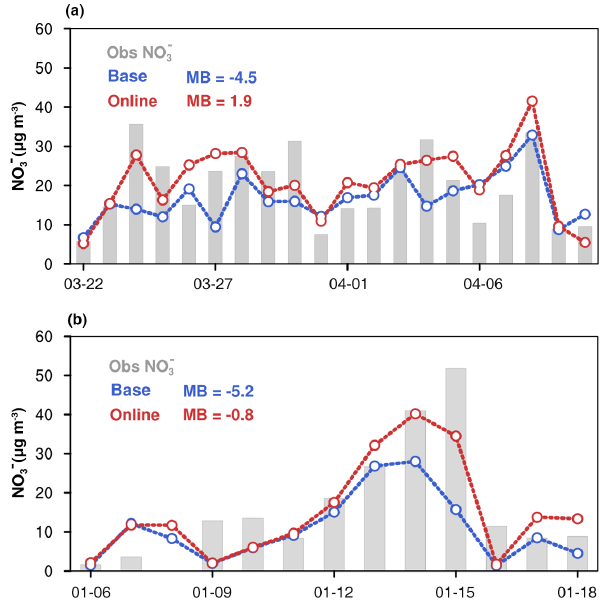
Figure 9. (a) Time series of nitrate (NO − ) concentrations from 3 22 March to 11 April 2019 in the Nanjing site. (b) Time series of ni- trate (NO − ) concentrations from 6–18 January 2015 in the Beijing 3 site. The gray bar represents the observation nitrate concentration, blue lines represent the nitrate concentration in the base simulation, and red lines represent the nitrate concentration in the online simu-